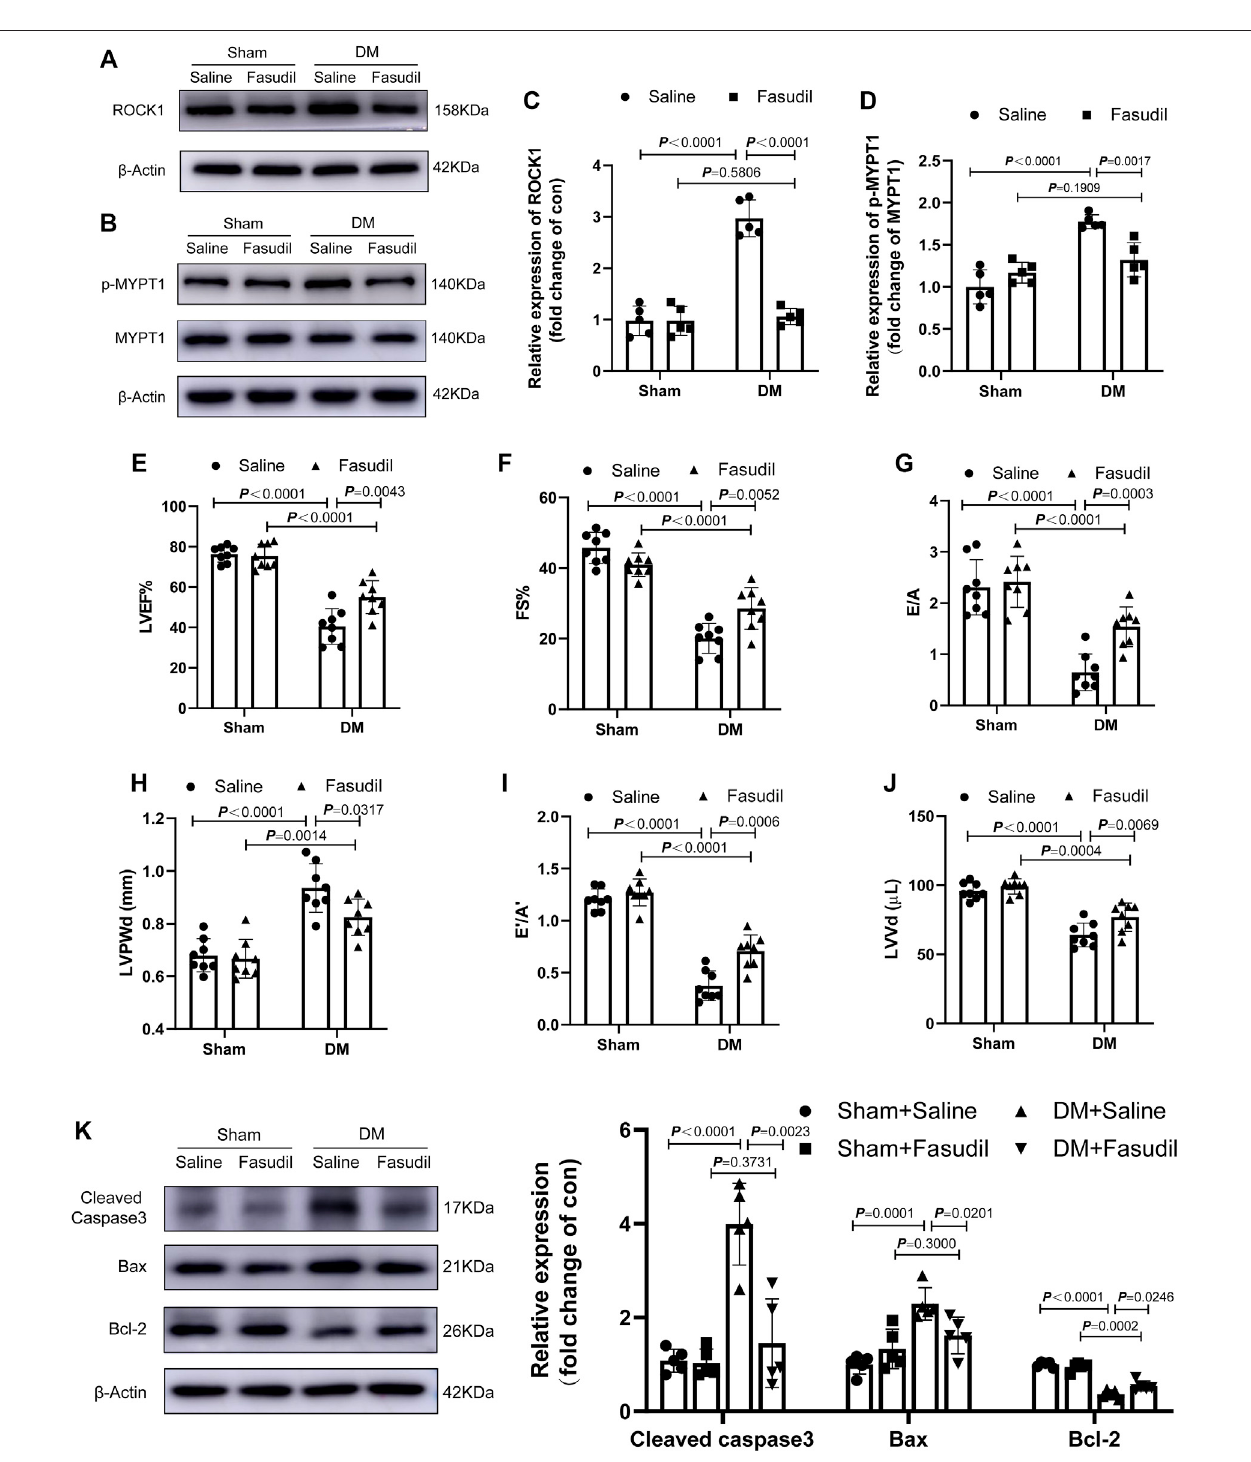
FIGURE2| FasudilimprovedDM-inducedcardiac dysfunction (A – D) Representativeimmunoblotsandquanti fi cation ofROCK1andp-MYPT1inthehearttissues of mice (n = 5) (E – J) Left ventricular ejection fraction (LVEF), fractional shortening (FS), and early (E ′ ) to late (A ′ ) diastolic velocity ratio (E ’ /A ′ ), peak E to peak A ratio (E/A), left ventricle end-diastolic volume (LVVd), as well as left ventricle end-diastolic posterior wall diameter (LVPWd), were evaluated using echocardiography (n = 8) (K) Representativeimmunoblotsandquanti fi cationofCleavedCaspase3,BaxandBcl-2inthehearttissuesofmice(n=5). p -valueswereadjustedforcomparisonsof multiple